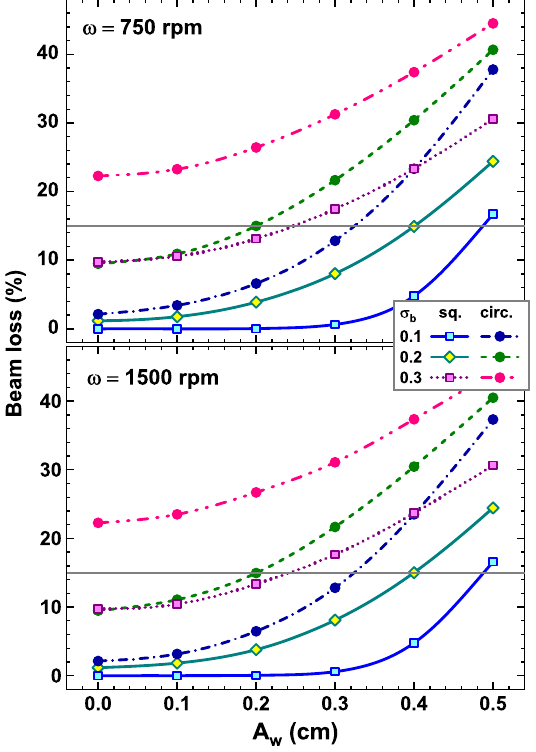
FIG. 15. Beam losses derived with MC simulations for beam widths σ b ¼ 0 . 1 – 0 . 3 cm, and wobbling amplitudes A w ¼ 0 – 0 . 5 cm as applied to the rotating target with R c ¼ 12 cm, for the velocities of 750 and 1500 rpm (upper and bottom panels, respectively), and different diaphragms installed in front of the target (symbols connected by lines). Data correspond to the square and circular diaphragm of the size of 1 × 1 cm and 1 cm in diameter designated as(sq.)and(circ.),respectively.Straightsolidlinescorrespondingto the 15% beam loss are shown in both panels for